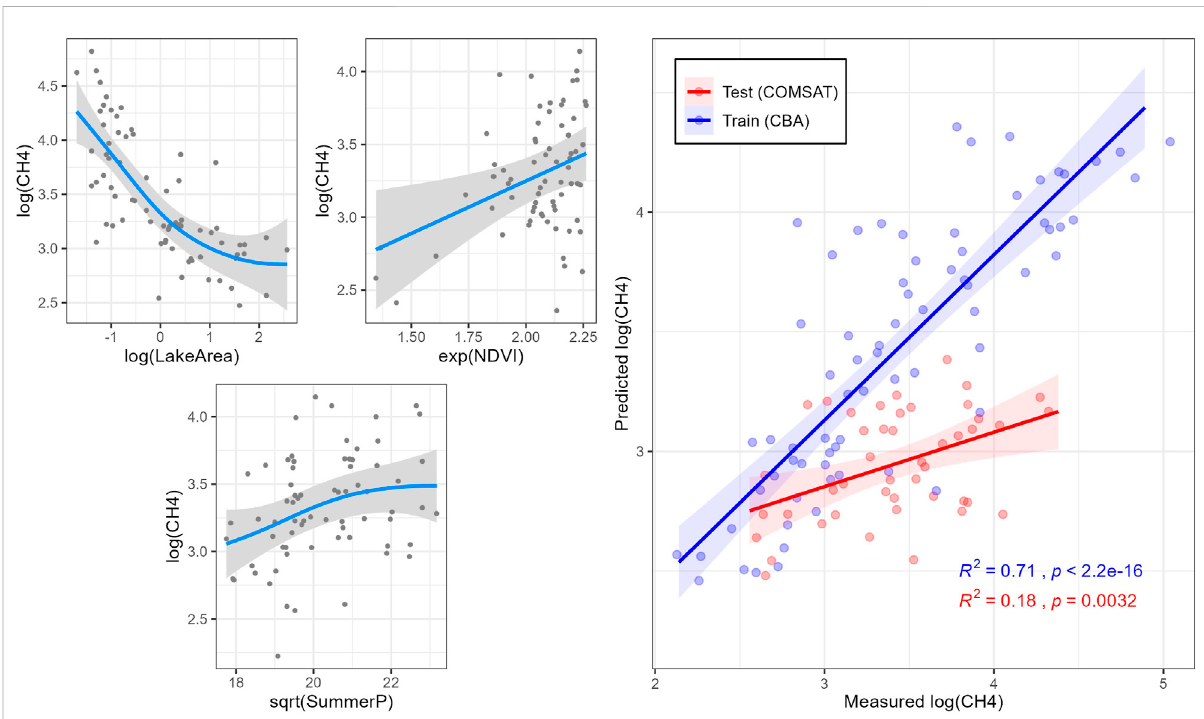
FIGURE 4 Simulations (blue lines) of normalized relative CH 4 saturations in the CBA dataset by generalized additive model (GAM) 1. On the right side, model training with CBA dataset (red) and test with COMSAT dataset (blue) for each model. Shaded gray areas indicate 95% con fi dence